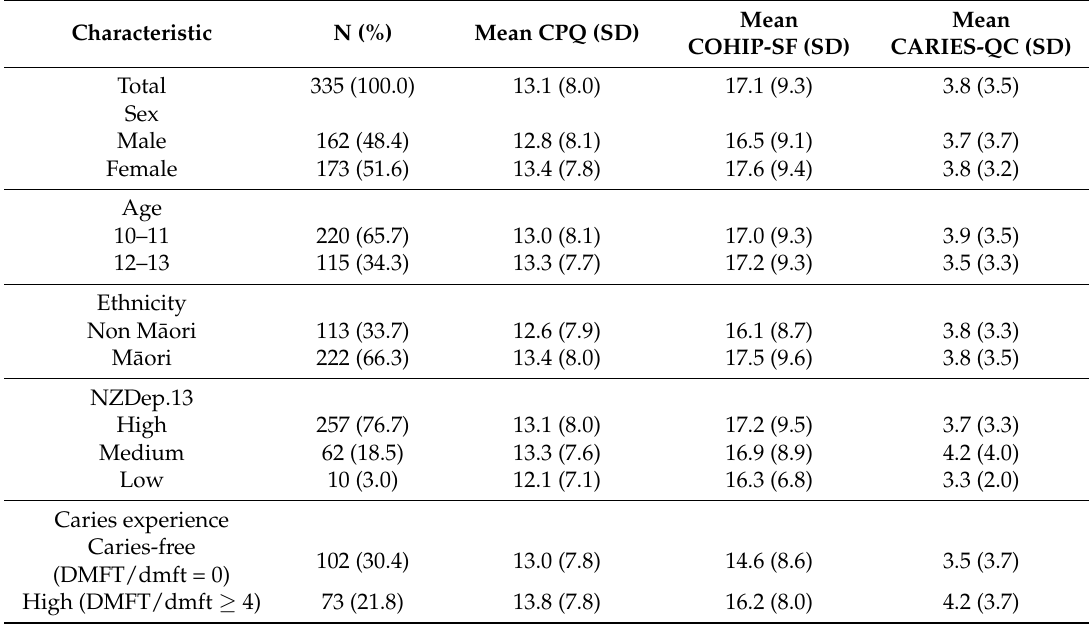
Table 3. Mean CPQ 11–14 , COHIP-SF and CARIES-QC scores by sociodemographic characteristics and caries experience.